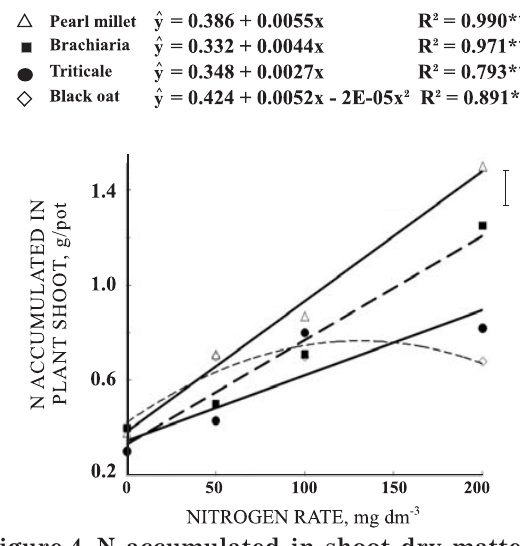
significant.Figure 4. N accumulated in shoot dry matter of different cover grasses as related to N fertilization, 54 days after sowing. Vertical bar show LSD comparing species (p ≥≥≥≥≥ 0.05). ** R 2 significant (p ≤≤≤≤≤ 0.001); ns R 2 non